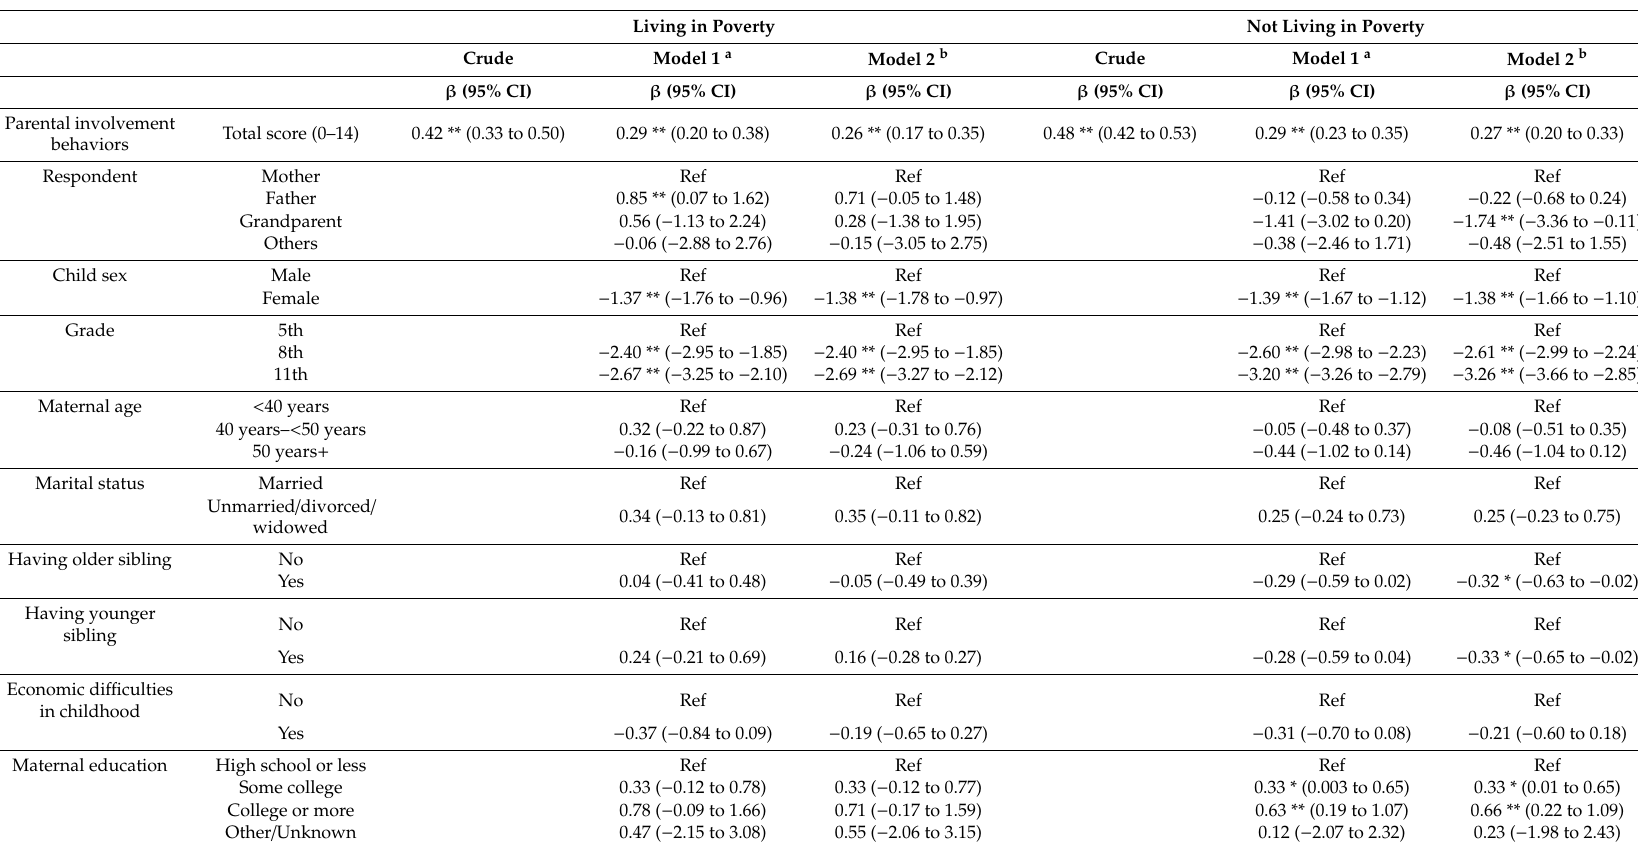
Table 3. The association between the total number of parental involvement behaviors and self-esteem among adolescents living in poverty ( n = 3696) and not living in poverty ( n =